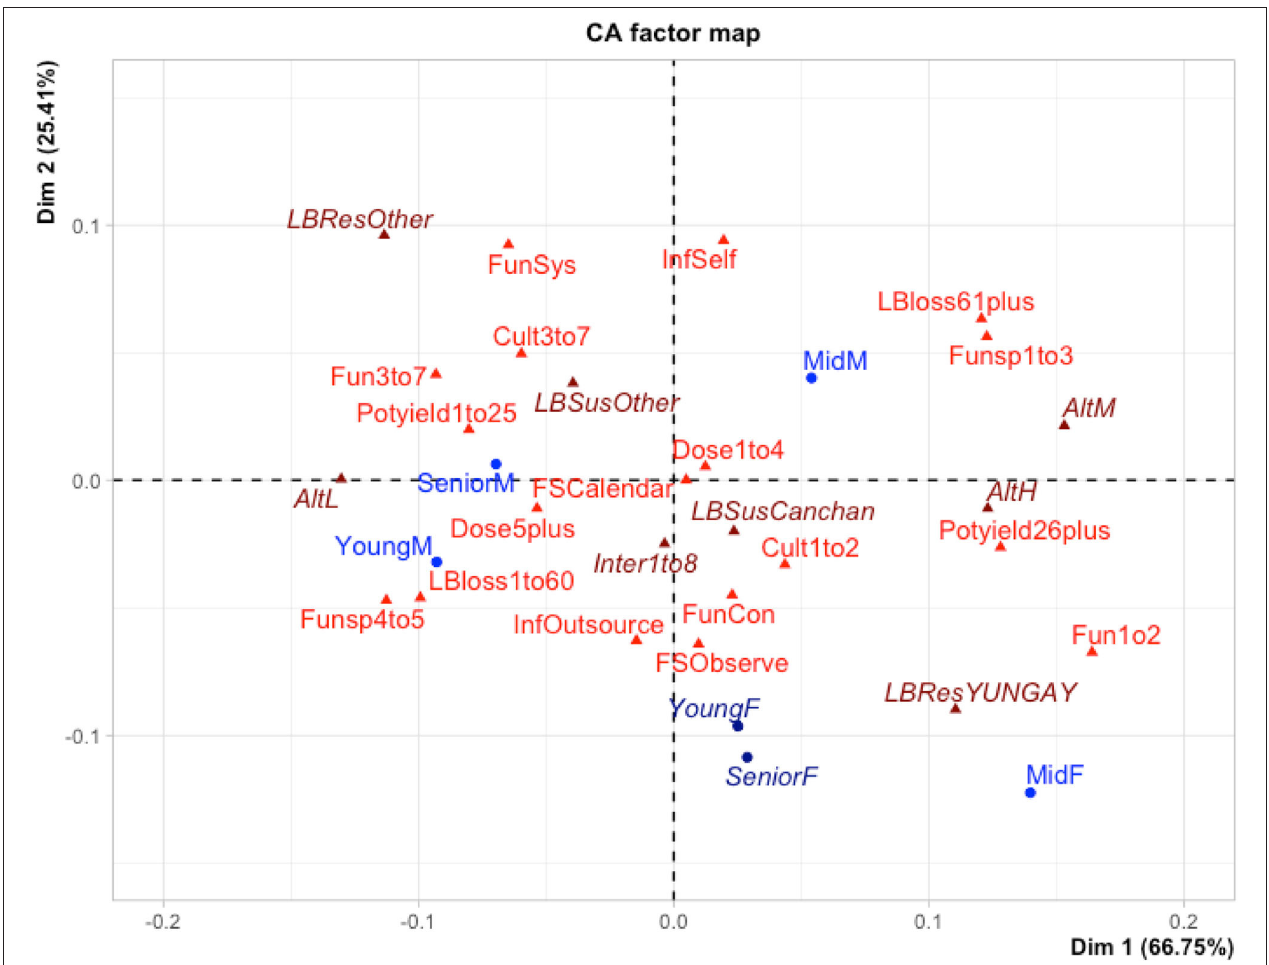
FIGURE 7 | Correspondence analysis biplot for characteristics and responses of respondents from Paucartambo. Color code: dark blue, respondent age-gender classes that form the rows in the contingency table; light blue, respondent age-gender classes used as supplementary rows; red, management choices in the form of discretized variables that form the columns in the contingency table; brown, management choices used as supplementary